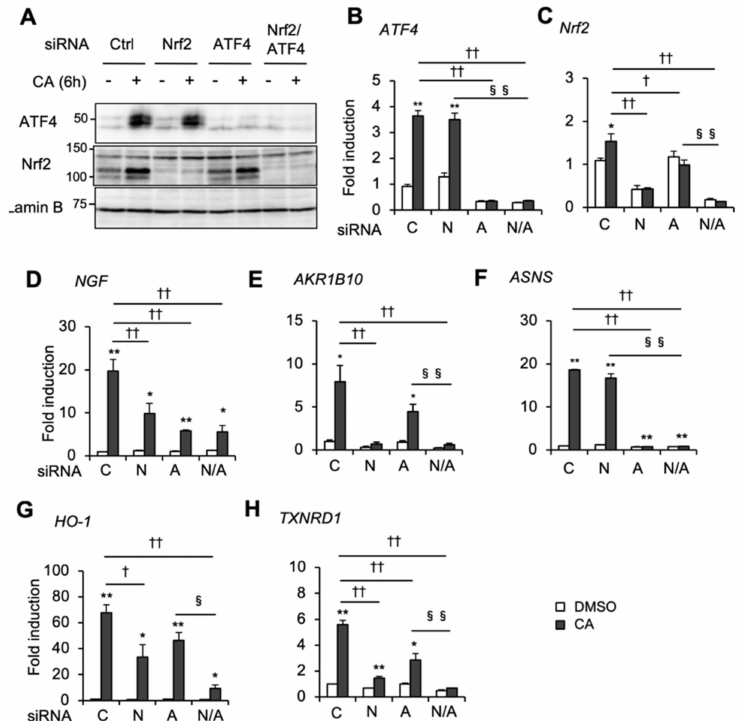
Figure 3. Nrf2 and ATF4 cooperatively modulate CA induction of NGF and antioxidant genes. ( A ) ATF4 and Nrf2 protein levels in ATF4 and/or Nrf2 knockdown cells. U373MG cells were